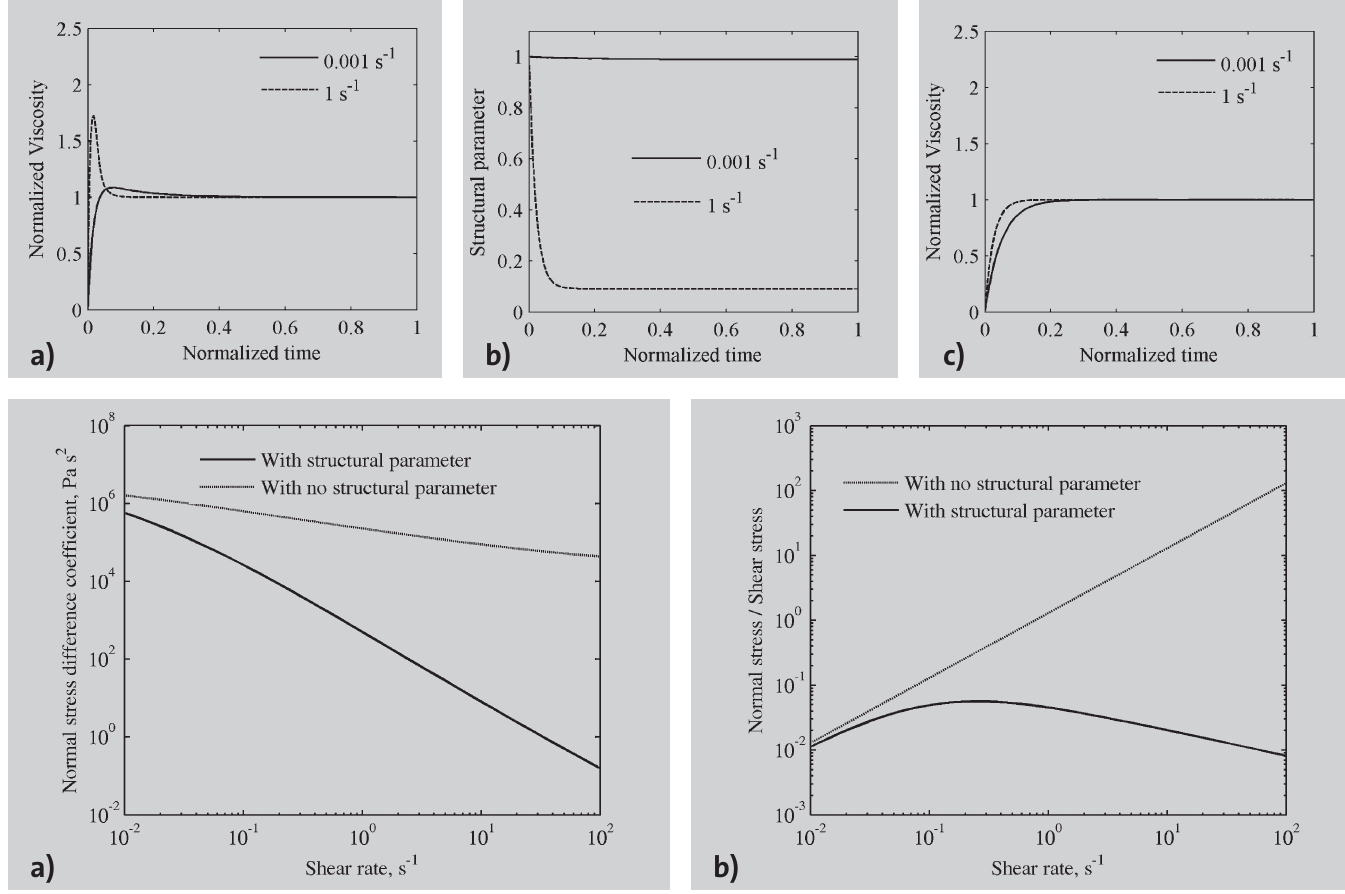
Figure 2 (above): (a) Stress growth during steady shear at different shear rates (parameters for Asphalt 1; Table 1). (b) Variation of structural parameter during stress growth experiment. (c) Stress growth during steady shear, with no varia- tion in structural parameter ( l = 1) at different shear rates. Figure 3 (below): (a) Variation of normal stress coefficient as a function of shear rate with and without structural parameter. (b) The ratio of normal stress to shear stress for White Metzner model with and without the variation of structural parameter (parameters for Asphalt 1, Table